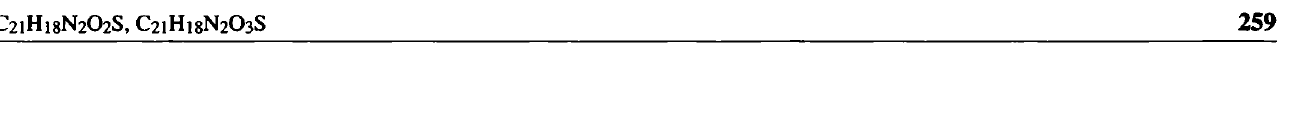
Table 1. Data collection and handling.